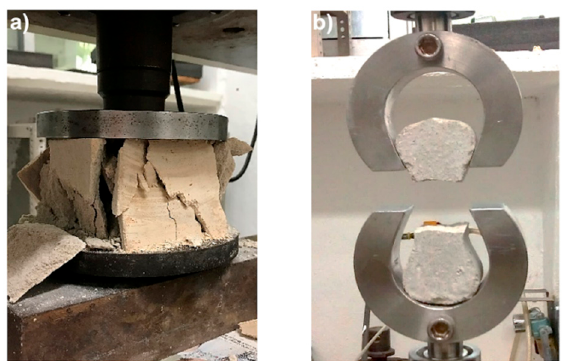
Figure 3. Plain foamed concrete (PFC) specimens: ( a ) after the compression test and ( b ) after the tension test.